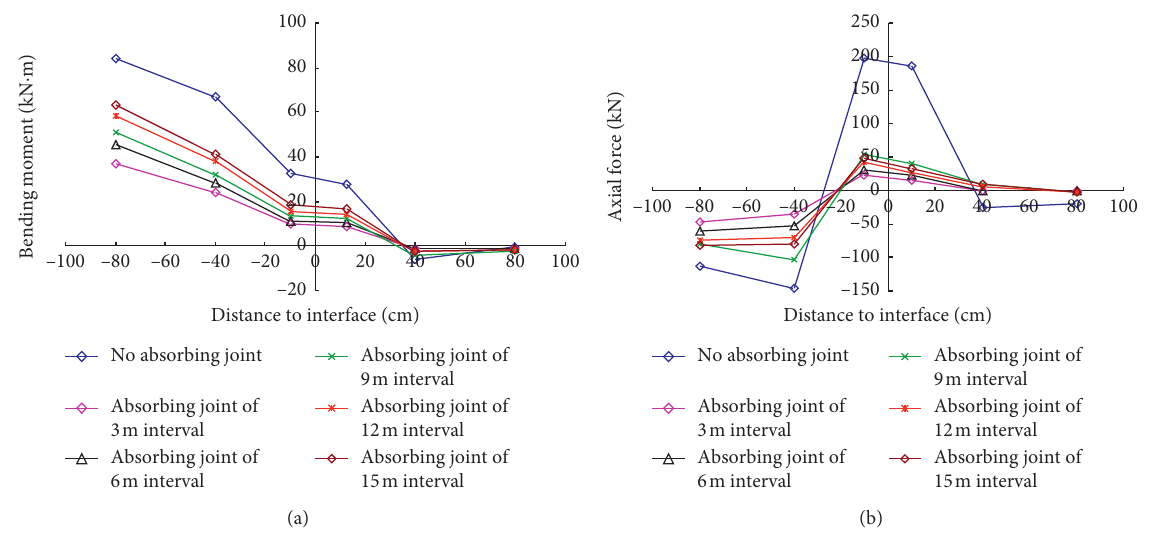
Figure 13: Internal force of tunnel vault at each monitoring section. (a) Bending moment of vault. (b) Axial force of vault.